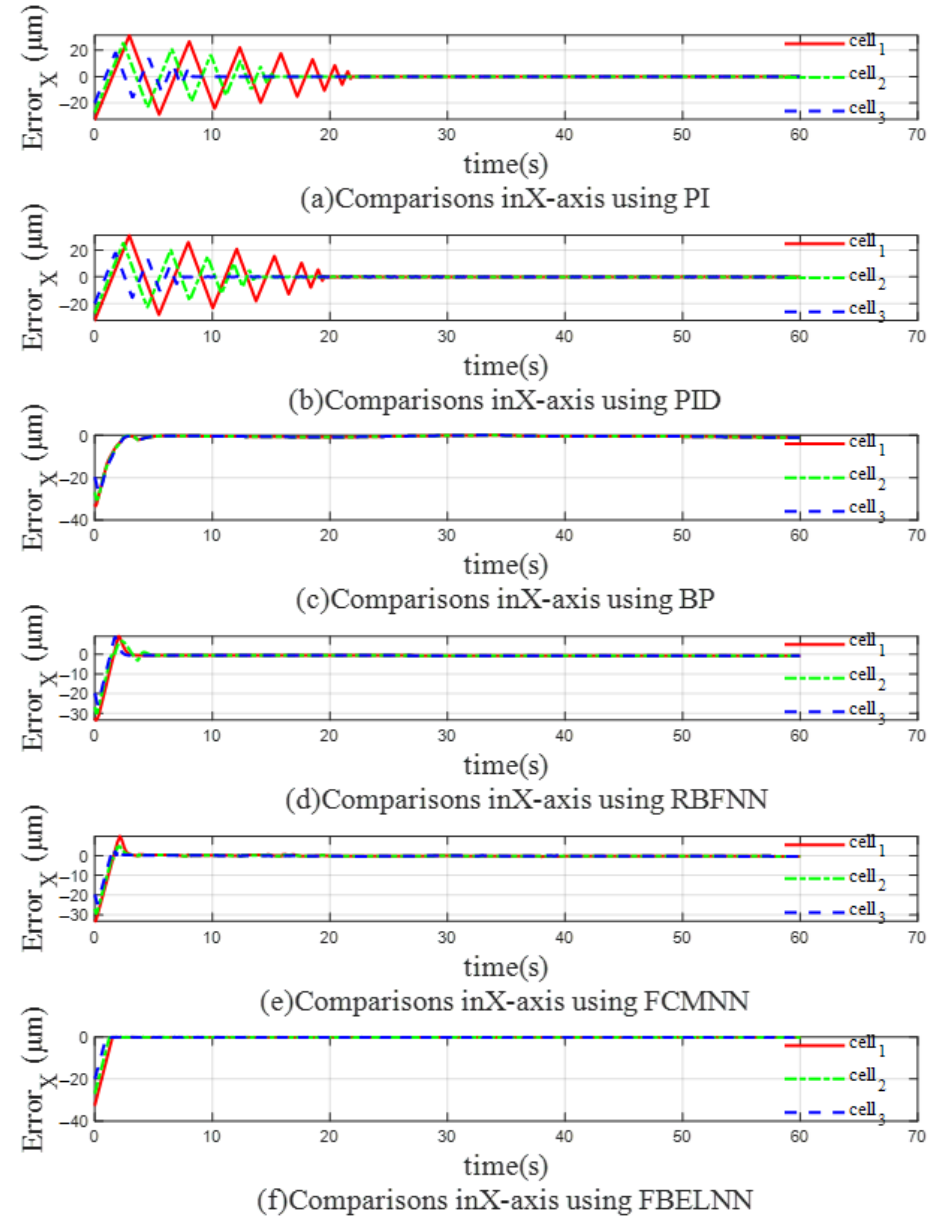
Figure 12. The trajectory error on the X -axis (multicellular manipulation): ( a ) Use PI as a controller. ( b ) Use PID as a controller. ( c ) Use BP as a controller. ( d ) Use RBFNN as a controller. ( e ) Use FCMNN as a controller. ( f ) Use FBELNN as a controller.